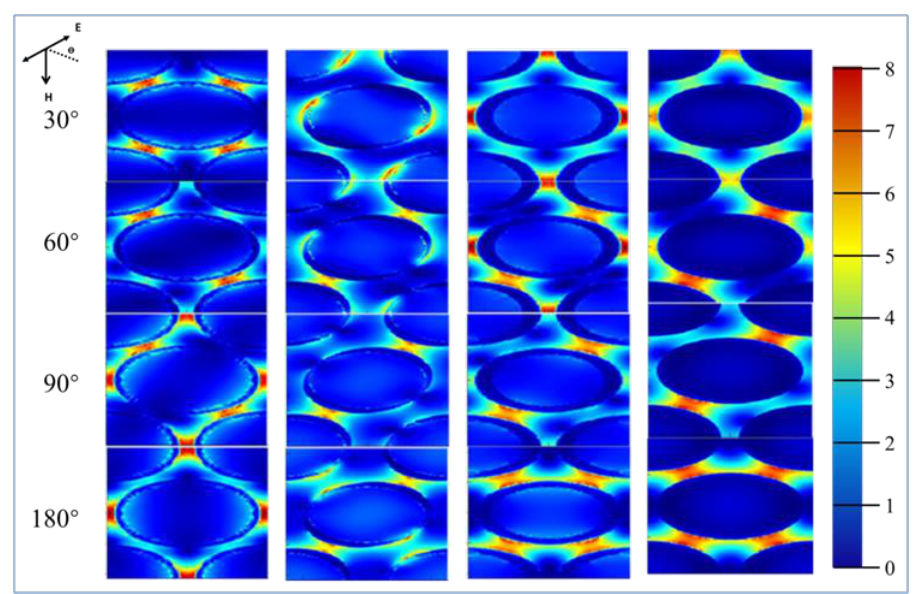
Figure 4. The electric field intensity under a polarized light source of FDTD simulations.